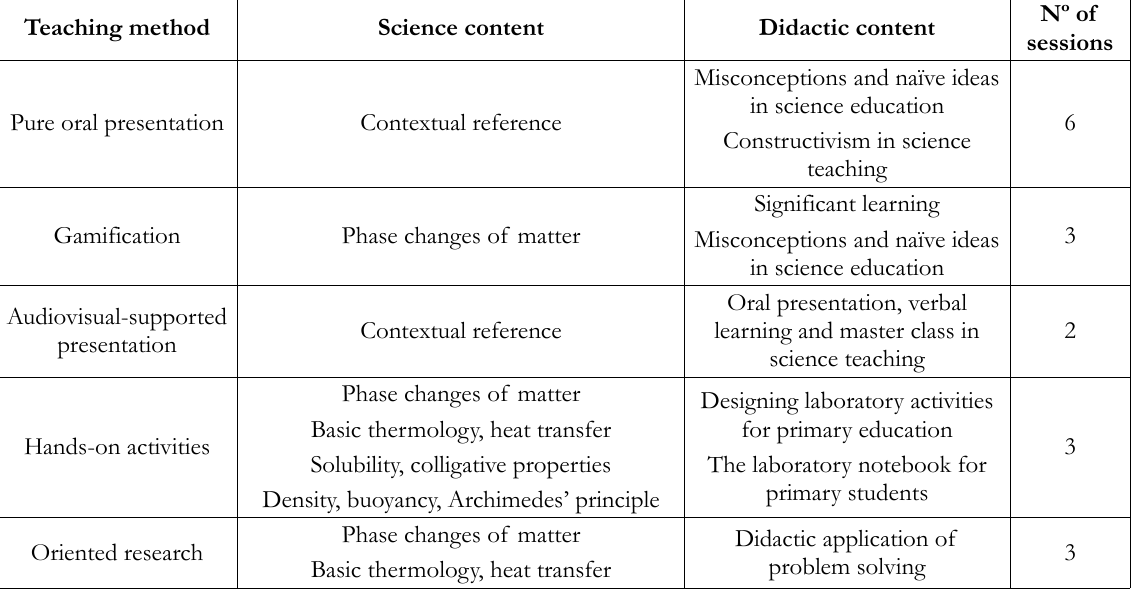
Table 1. Distribution of the content in each teaching